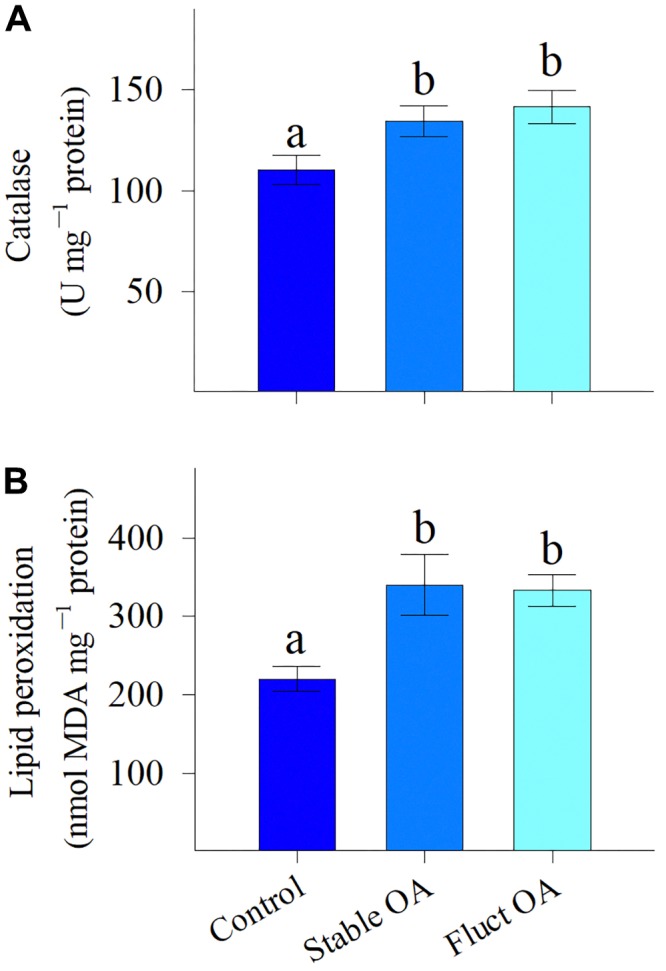
(A) Activity of the antioxidant enzyme catalase and (B) levels of lipid peroxidation of P. damicornis recruits exposed to ambient pCO2 (Control), steady-high pCO2 (Stable OA), and fluctuating-high pCO2 (Fluct OA). Data shown as mean ± SE. Different letters indicate statistically significant differences in mean values among treatments.